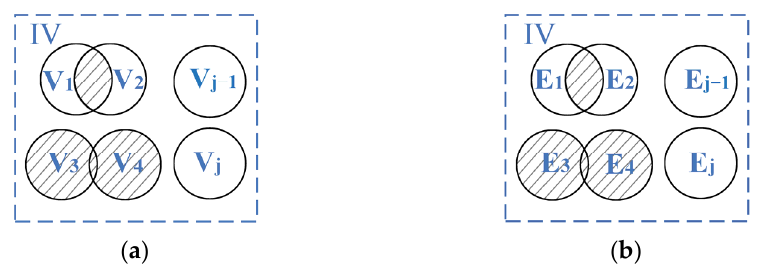
Figure 3. The function and effect relationship: ( a ) function relationship; ( b ) effect relationship.